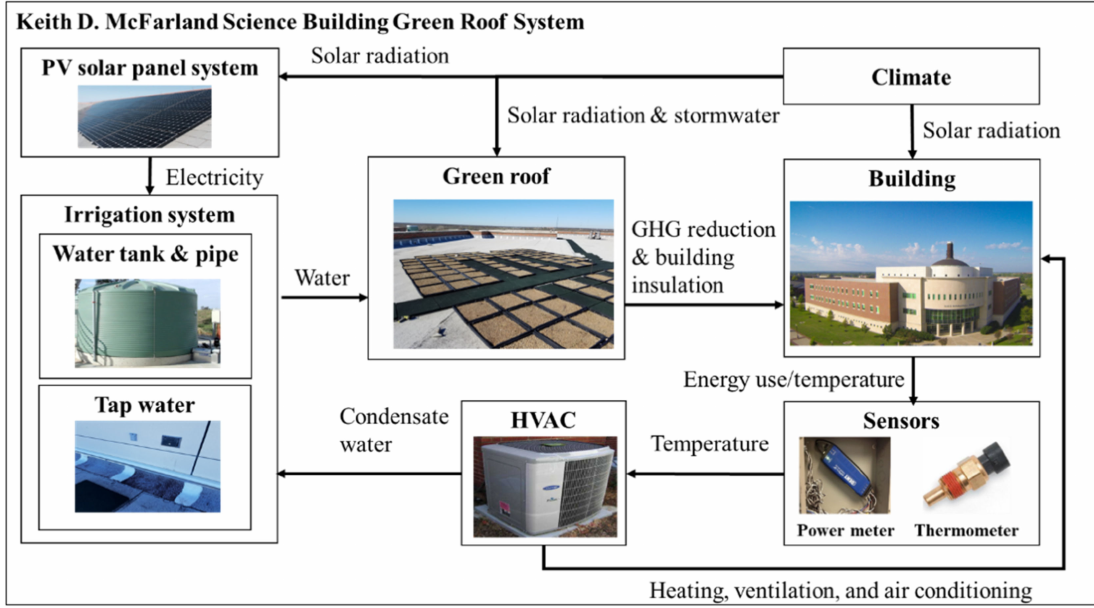
Figure 3. Proposed sustainable green roof